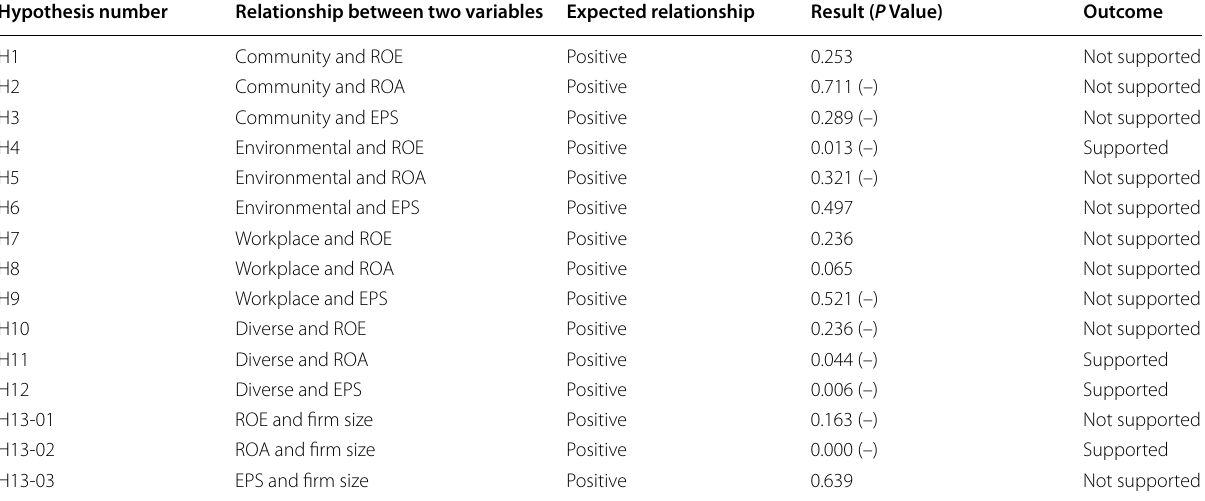
Table 10 Summary of the hypotheses tested Hypothesis